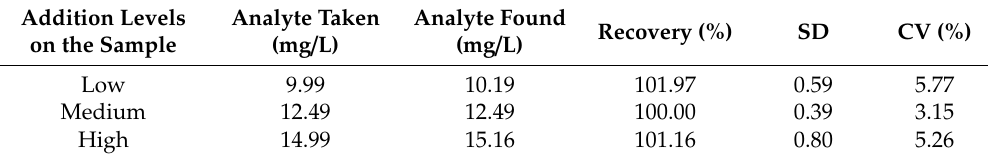
Table 1. Results of an accuracy and precision study using the standard addition method.